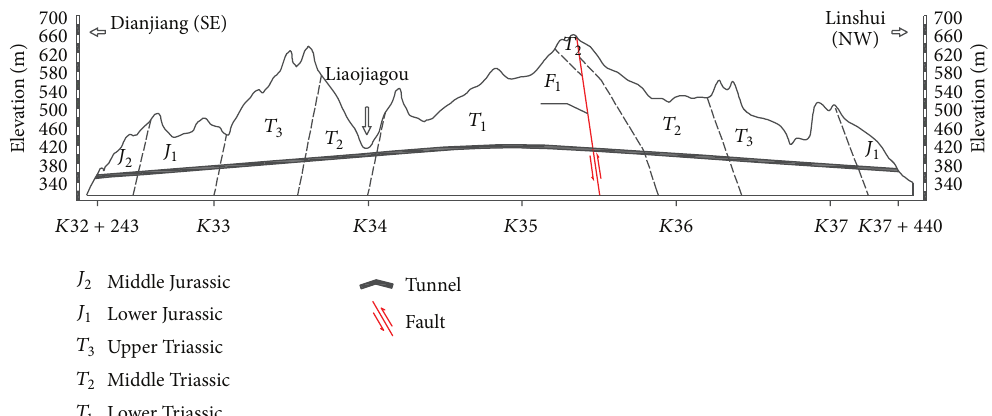
Figure 2: Geological profile of Tongluoshan